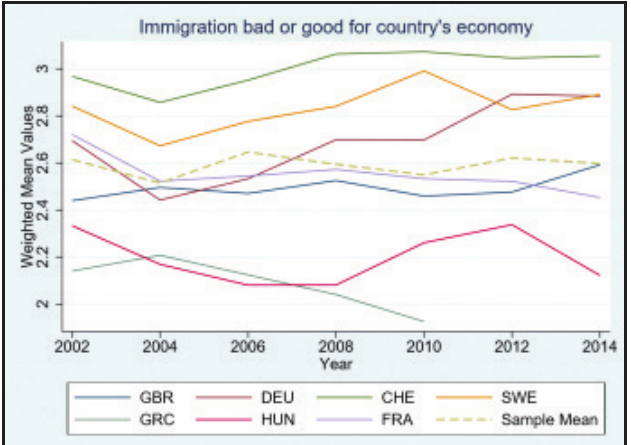
Figure A2 Trends of European attitudes toward